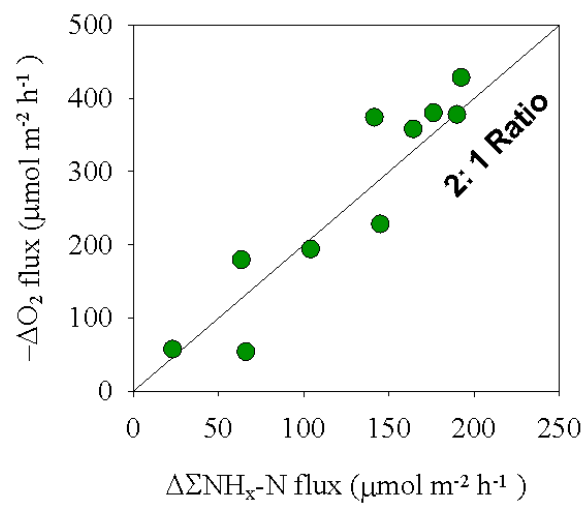
Fig. 7. The relationship between the increased P NH x fluxes and the reduced oxygen consumption rates after pH elevation. Data from Powerline site are the changes of P NH + same core after pH was elevated from 7.8 to 9.5. Data from Budds Landing site are the changes of flux rates between control cores and cores at the pH of 9.2 and 9.5 after 7 days incubation. The slope of the solid line is 2:1, which is equal to the molar ratio of ammonium to oxygen for nitrification (Eq.